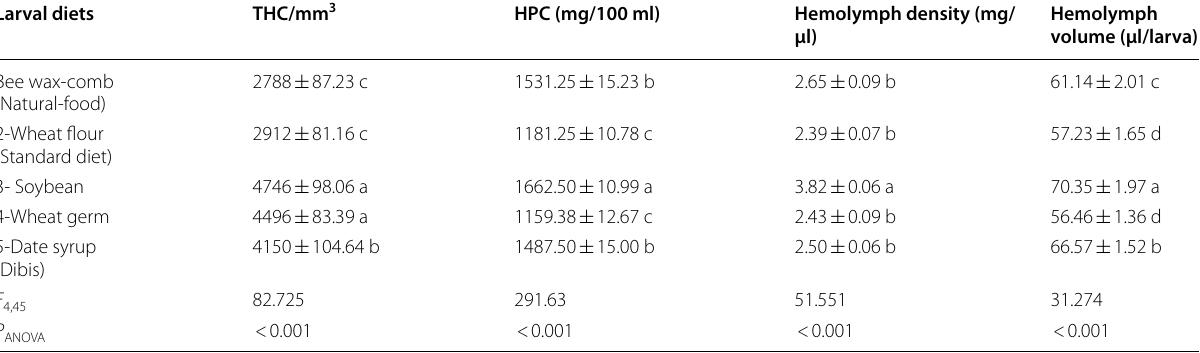
Means SE sharing the same small letters in the same columns are statistically insignificant ( p > 0.05) ±